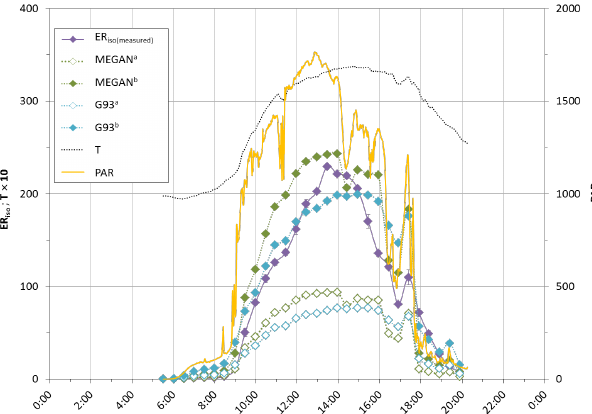
Figure 7. Comparison between Qp 4 isoprene emission rates ER iso (µgCg − 1 h − 1 ± SD) measured in situ (1 June, purple diamonds) DM and assessed using isoprene emission algorithm as in (i) Guenther et al. (1993) (G93, green diamonds) and as in (ii) MEGAN model (Guenther et al., 2006, blue diamonds) using a leaf age factor ϒ age of 0.6 and a soil water factor ϒ SM of 1. PAR (µmolm − 2 s − 1 ) and temperature T ( ◦ C) were recorded inside the enclosure. a Emission factor Is value is 53µgCg − 1 h − 1 (as in Simpson et al., 1999, open DM diamonds). b Emission factor Is value is 138µgCg − 1 h − 1 (this DM study, solid